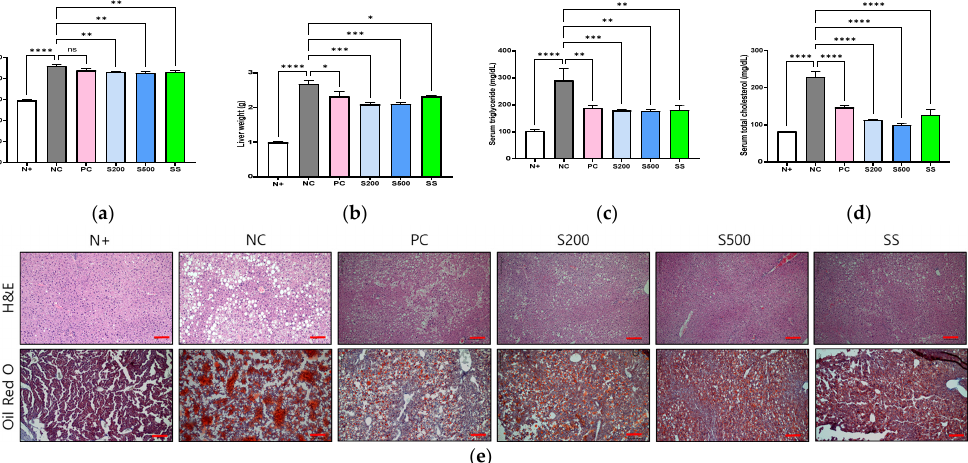
Figure 1. Stevia and stevioside attenuate lipid accumulation in db/db mice. Mice were orally administered saline (N+ and NC), saline with 200 mg/kg/day metformin (PC), saline with 200 or 500 mg/kg/day stevia (S200 and S500), and saline with 40 mM/kg/day stevioside (SS) for 3 weeks. ( a ) Body weight. ( b ) Liver weight. ( c ) Serum triglyceride (TG). ( d ) Serum total cholesterol (TC). ( e ) Image of liver tissues. All data are presented as the mean ± standard error (SE), n = 6 and represent results from three independent experiments. Scale bar, 100 μ m. * p < 0.05, ** p < 0.01, *** p < 0.001, and **** p < 0.0001.